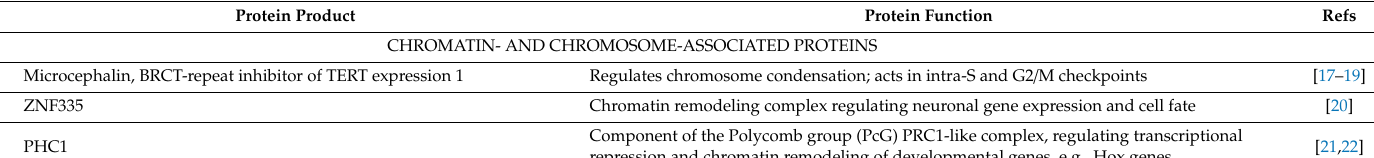
Table 1. Canonical microcephaly-associated gene products, localization, and